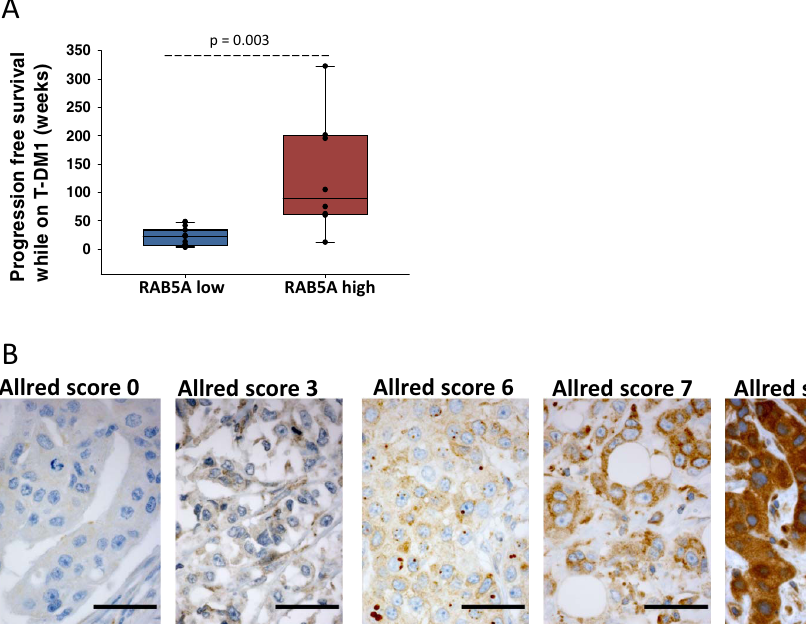
Fig. 6 T-DM1 and RAB5A correlation in a subset of patients in KAMILLA. A Box blot indicating the distribution of PFS in RAB5A low (Allred score 0 – 6, N = 11 independent samples) and RAB5A-high (Allred score 7 and 8, N = 8 independent samples) expressing patients. The midline represents the median of progression-free survival. The upper and lower limits of the box correspond to the 75% and 25% percentile of progression-free survival respectively; the whiskers represent the 90% and 10% percentile. The data points represent the individual data points in each group. A Mann – Whitney rank-sum test was used to determine the statistical difference in the median values between the two groups. B Exempli fi ed images (×40 objective) of RAB5A IHC for Allred score 0 (patient #20), Allred score 3 (patient # 19), Allred score 6 (patient #21), Allred score 7 (patient #24) and Allred score 8 (patient #15). Scale bars: 100 µ m. All samples were manually screened by 2 observers. Consensus on staining intensity and amount was obtained, and representative areas de fi ned. Number of images captured from each slide: patient #20 4 images, patient #19 10 images, patient #21 8 images, patient #24 6 images, patient #15 4 images. Source data are provided as a Source Data fi